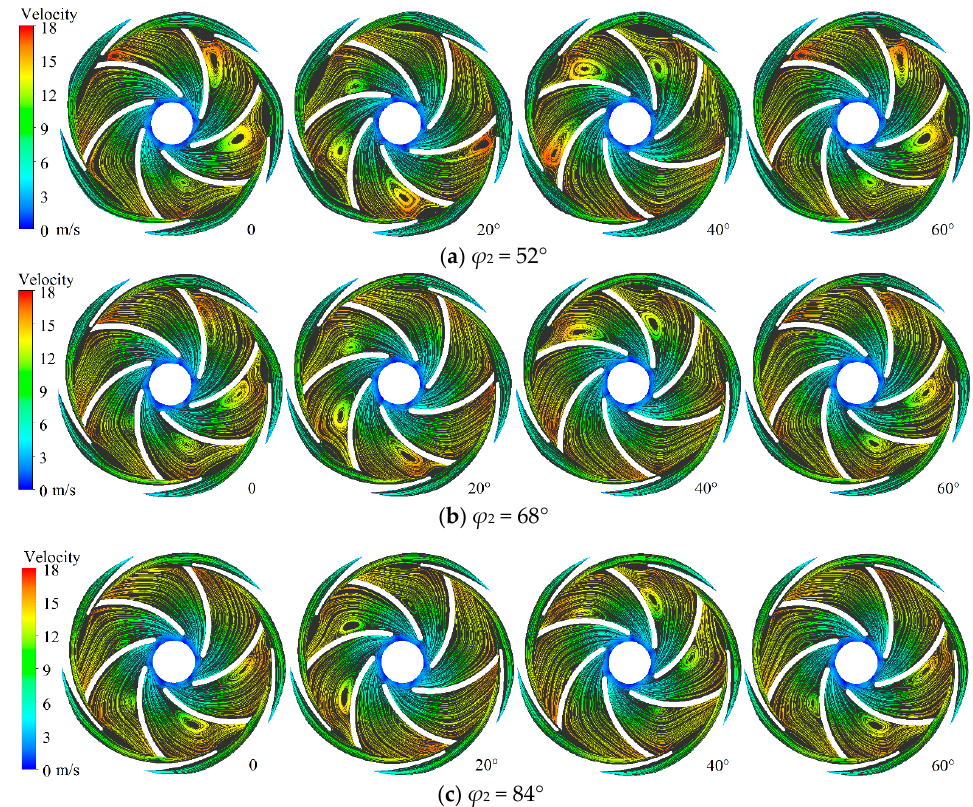
Figure 17. Evolution processes of the transient flow field inside the impeller and guide vane with different wrap angles of the positive guide vane.